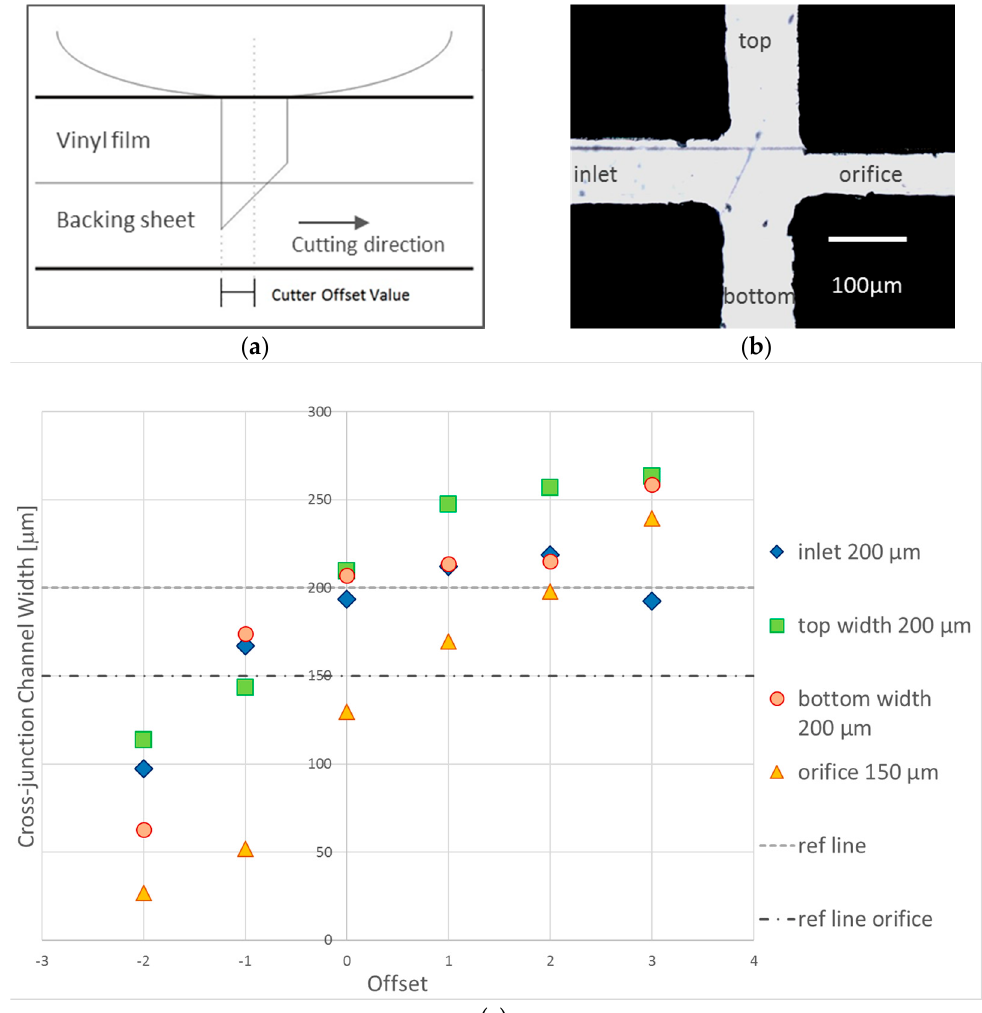
Figure 4. ( a ) Schematic illustration of the cutting mechanism of the cutter plotter; ( b ) vinyl film cutting at the optimal offset value 0; and ( c ) graph of cutting plotter offset versus cross-junction channel width. The reference (ref.) line refers to the desired width for the top, bottom and inlet channel i.e., 200 µ m while the orifice width is at 150 μ m. At the offset of 0 value, the errors of the channel widths produced towards the desired were below the 5% acceptable range.